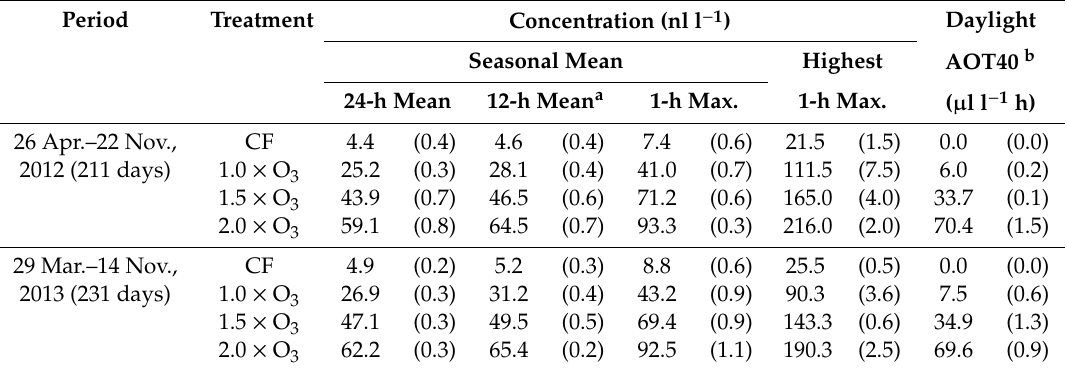
Table 2. O 3 concentrations and AOT40 of O 3 during the O 3 -exposure period in 2012 and 2013. Period Treatment Concentration (nl l − 1 ) Daylight Seasonal Mean Highest AOT40 b 24-h Mean 12-h Mean a 1-h